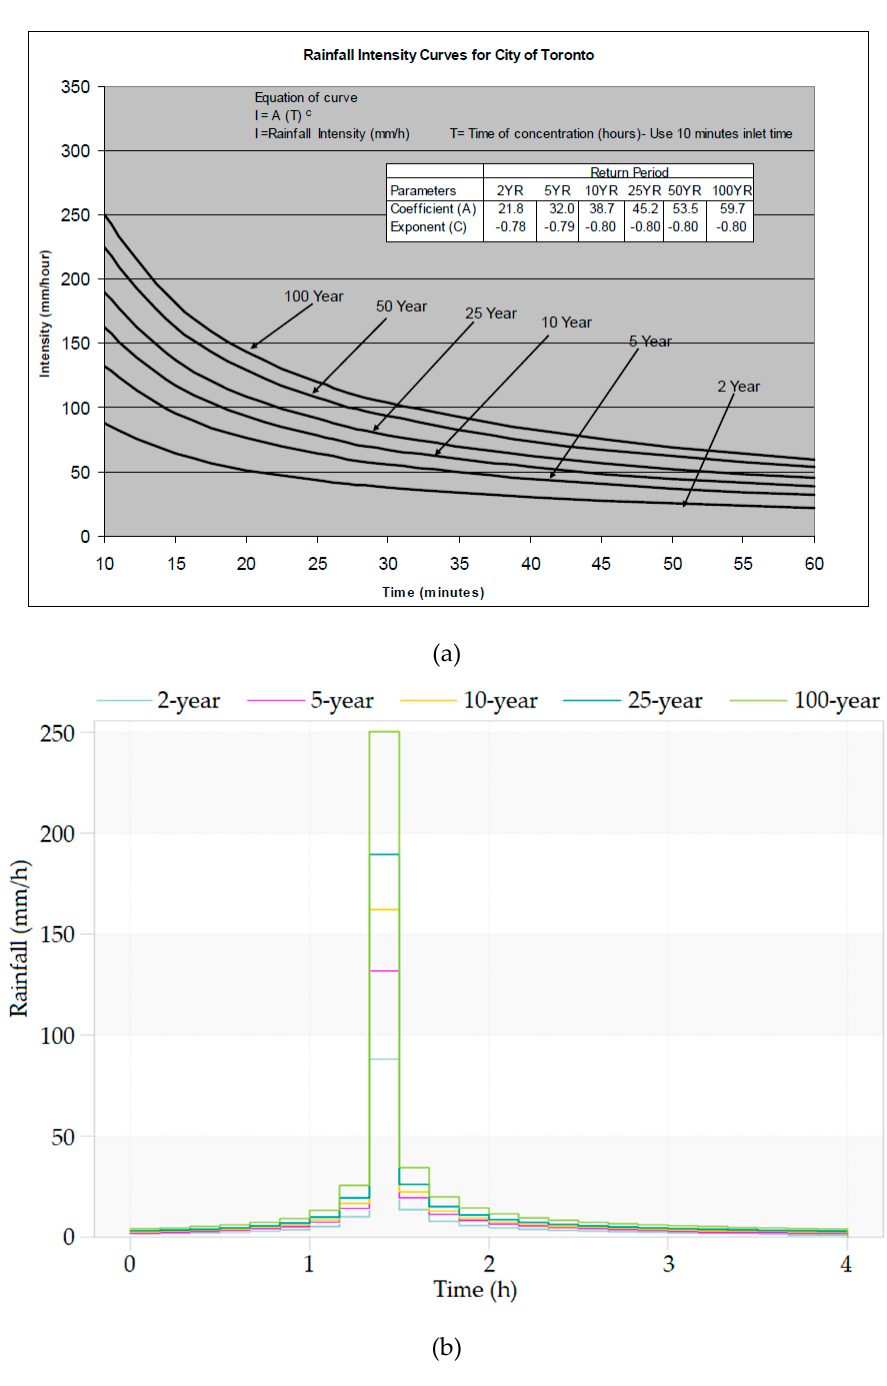
Figure 5. ( a ) Toronto Intensity-Duration-Frequency curves; and ( b ) Chicago Design Storms.